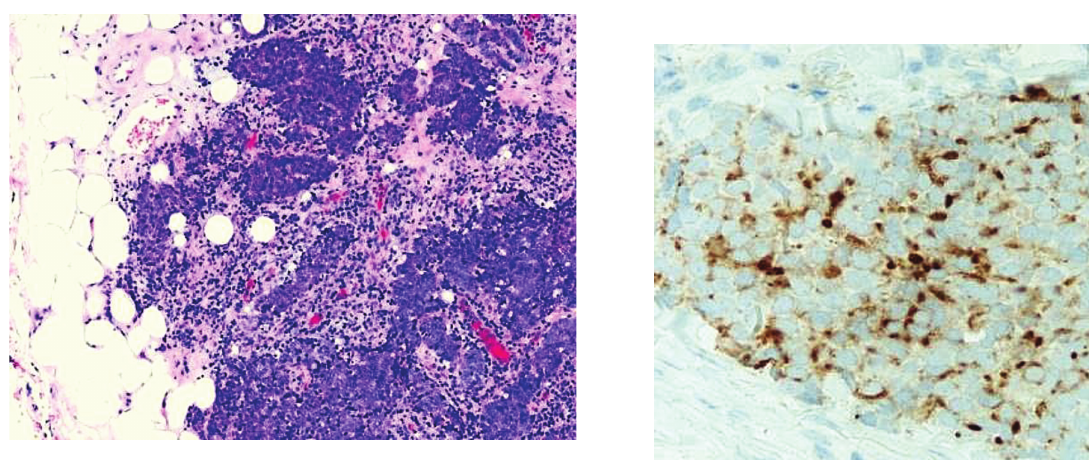
Figure 2: Undi ff erentiated dark epitheliod neoplastic infiltrates within the adipose tissue.